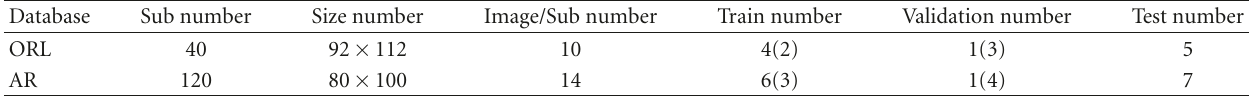
Table 1: General information and settings of the used databases.